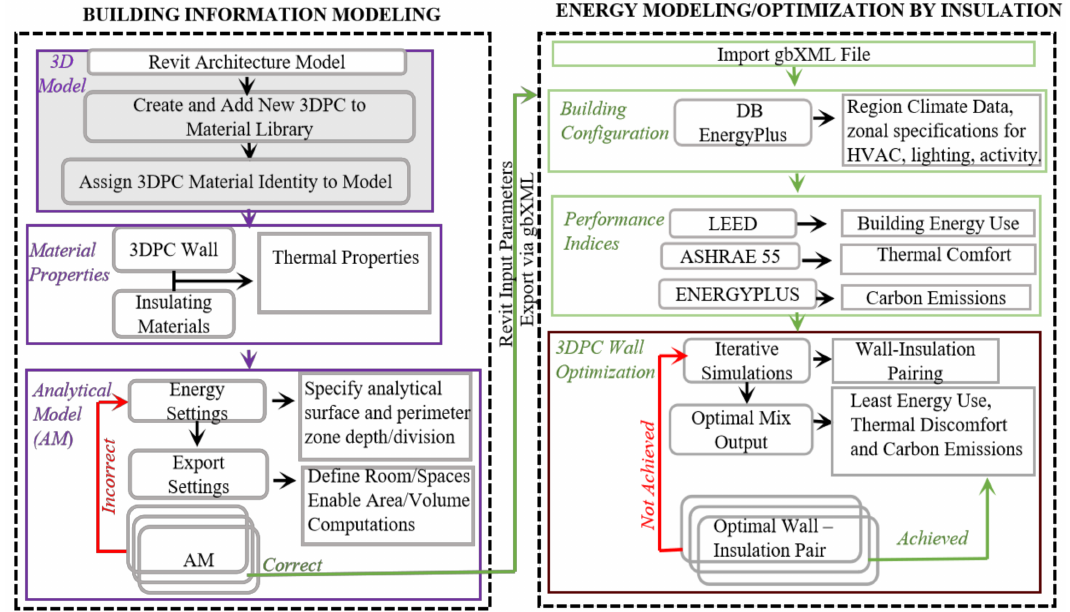
Figure 1. A flowchart showing the stepwise approach of the numerical